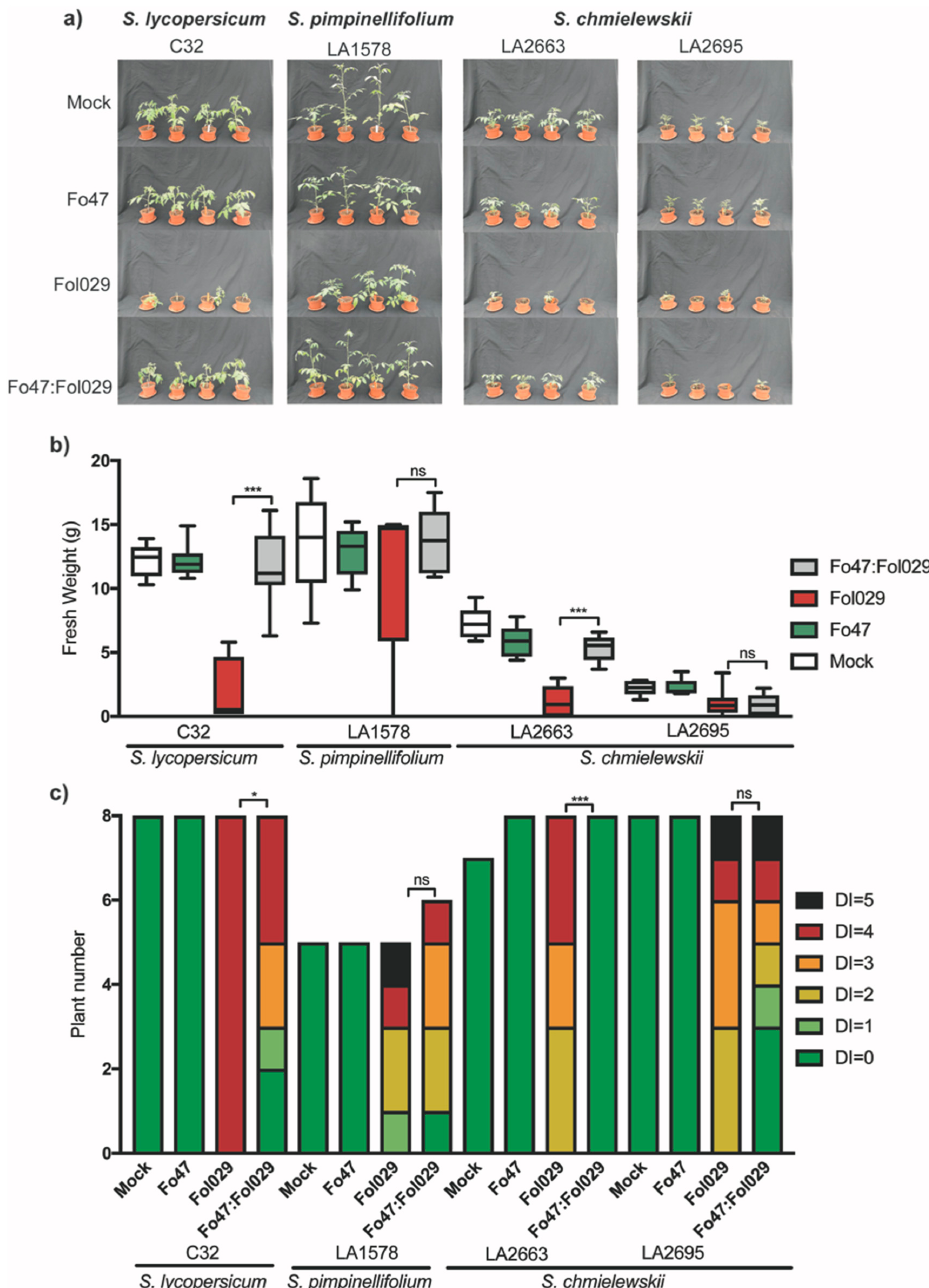
Figure 1. Fo47 can trigger resistance against Fol029 in ( a ) Solanum lycopersicum (C-32) and S. chmielewski (LA2663, LA2695). Thirteen-day-old tomato seedlings were inoculated with water (mock), Fo47, or Fol029, or coinoculated with Fo47 and Fol029. ( b ) Fresh weight and ( c ) disease index (DI) were assessed three weeks after inoculation where DI = 0 no brown vessels; DI = 1 brown vessel(s) only at basal level; DI = 2 one or two brown vessels at cotyledon level; DI = 3 three brown vessels at cotyledon level; DI = 4 all vessels are brown; DI = 5 the plant is dead. Data were analysed by a nonparametric Mann–Whitney U-test ( ns P > 0.05; * p < 0.05; *** p <